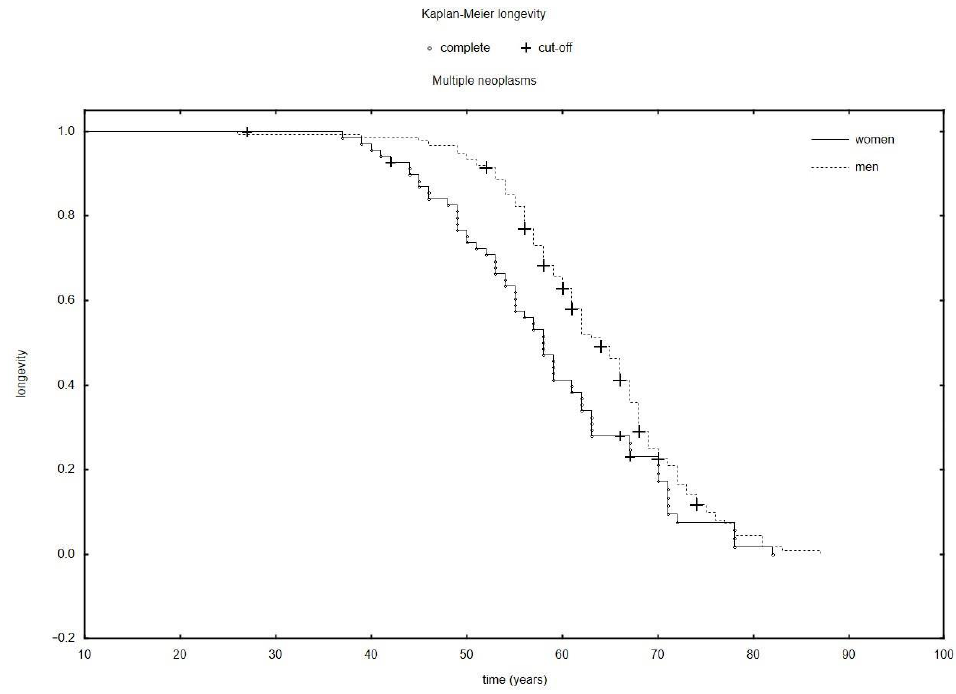
Figure 2. The Kaplan – Meier longevity in a population of women and men with multiple neoplasms.